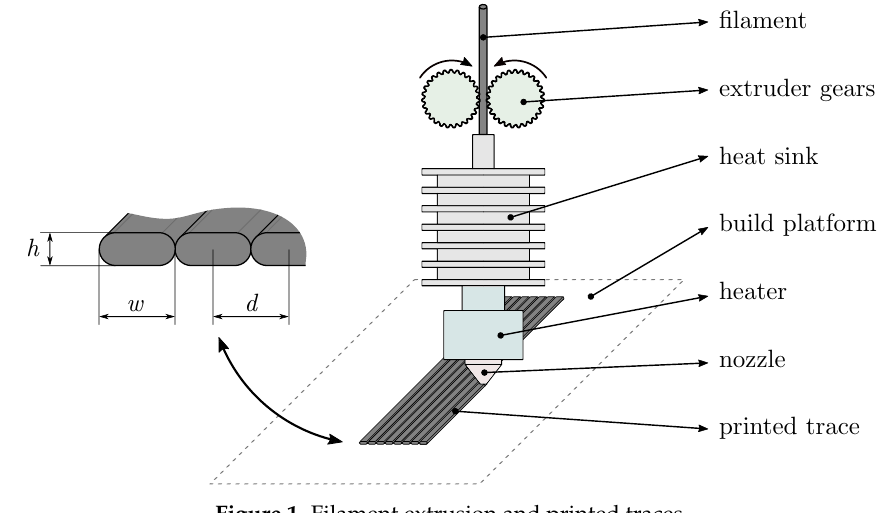
Figure 1. Filament extrusion and printed traces.